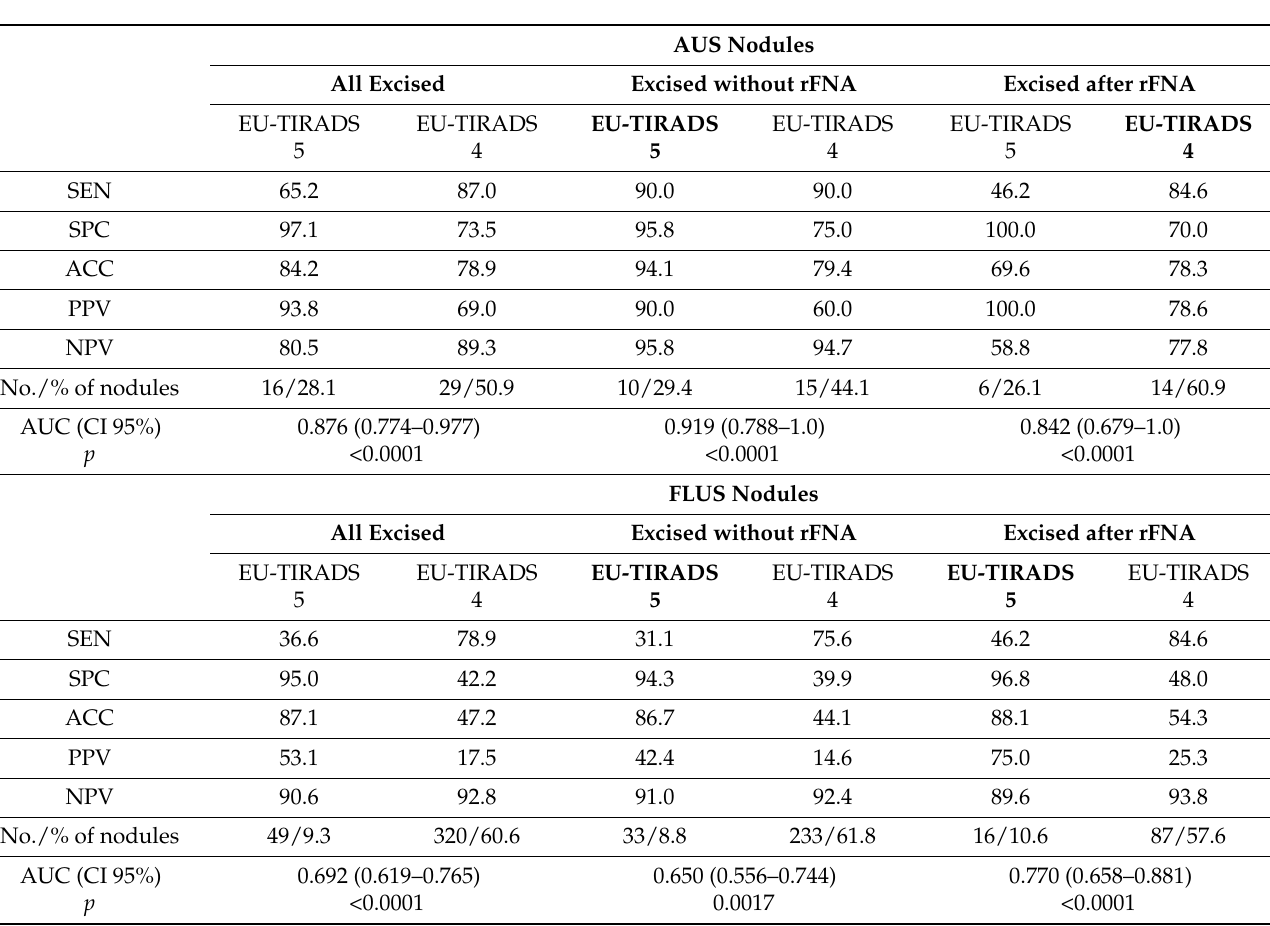
Table 4. Diagnostic effectiveness of EU-TIRADS for all excised AUS and FLUS nodules, evaluated for nodules excised without and after rFNA. Cut-off categories showing the highest ACC are marked with bold. AUS Nodules All Excised Excised without rFNA Excised after rFNA EU-TIRADS